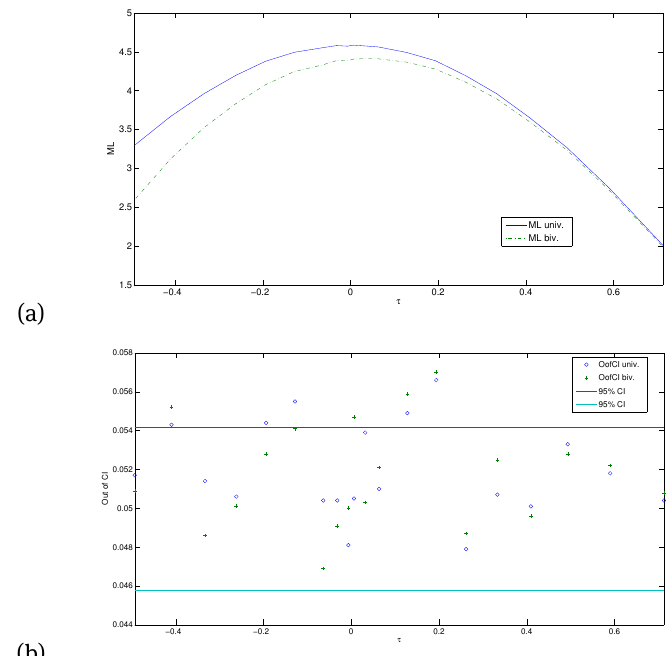
α N . Panel (b) gives the proportion of ob-